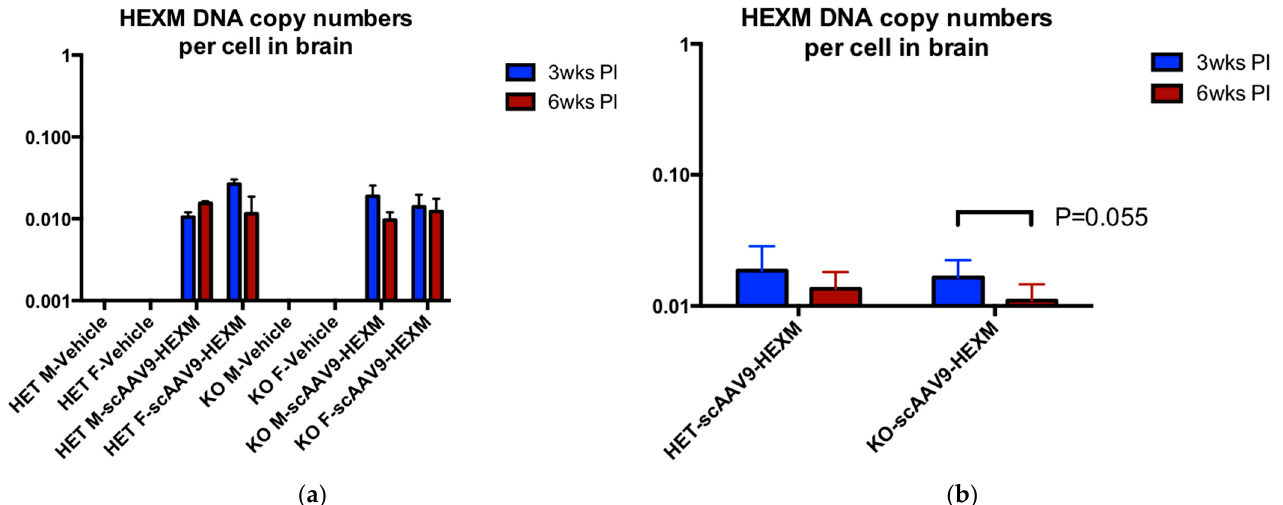
Figure 6. Vector biodistribution of scAAV9 ‐ HEXM in the brain of TSD mice. Biodistribution of the scAAV9 ‐ HEXM viral vector, in the brain, 3 weeks and 6 weeks post scAAV9 ‐ HEXM injection in TSD mice. ( a ) Comparison of scAAV9 ‐ HEXM treated to vehicle injected mice. ( b ) comparison of Het and KO mice. A lower biodistribution was obtained in brain samples from KO mice terminated at the later time point compared to the earlier time point, with this observation near to traditional significance levels ( p = 0.055). M = male, F = female, wks = weeks, PI = post injection.